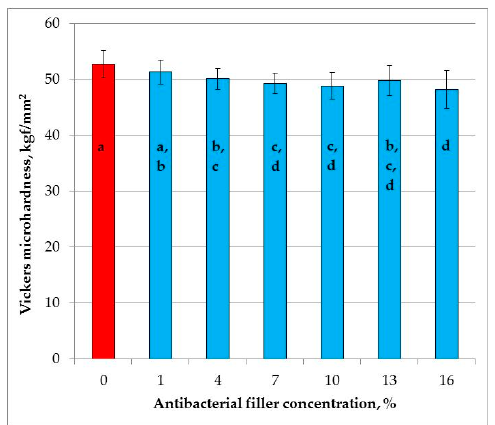
Figure 6. Mean Vickers microhardness values with standard deviations; different lowercase letters show significantly different results at the p < 0.05 level.